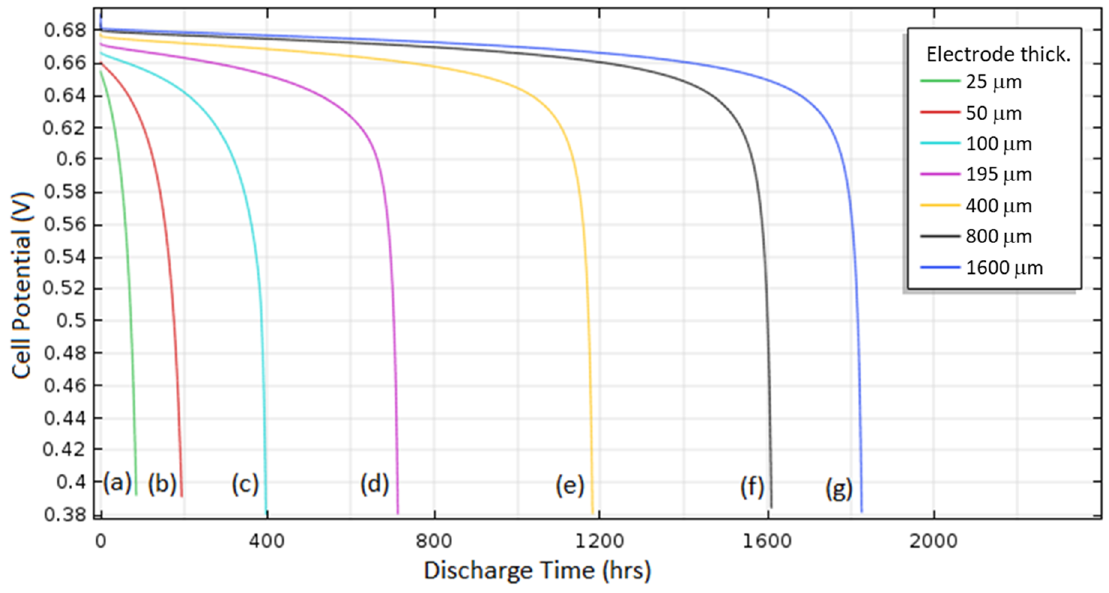
Figure 13. Discharge curves at 1 A / m 2 for cathode thicknesses of (a) 25, (b) 50, (c) 100, (d) 195, (e) 400, (f) 800, and (g) 1600 µ m, with 0.49 O 2 solubility and 0.73 cathode porosity.